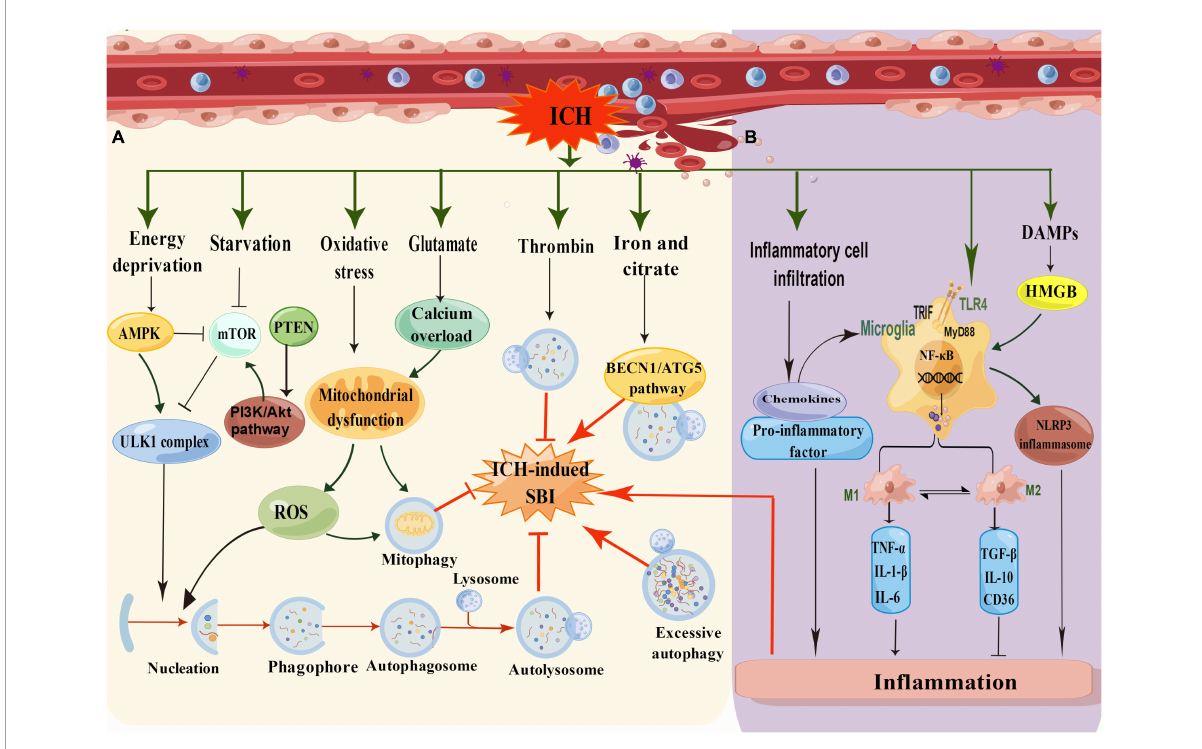
FIGURE3 (A) Schematic illustration of the mechanism of autophagy in ICH. In low energy states, the increasing ratio of AMP/ATP leads to the activation of AMPK and subsequently inhibits mTOR for induction of autophagy. In addition, the AMPK pathway suppresses mTOR activity, while the cell undergoes induction of starvation or calcium signals. After ICH, oxidative stress produces many ROS, and glutamate causes calcium overload, resulting in mitochondrial damage and inducing mitophagy. Thrombin can reduce SBI by inducing autophagy, whereas iron and citrate can induce autophagy to aggravate SBI through the BECN1/ATG5 pathway. (B) Schematic illustration of the mechanism of inflammation in ICH. The inflammatory mechanisms after ICH mainly include microglia activation, inflammatory cell infiltration, toll-like receptor activation, and DMPs mode regulation (by